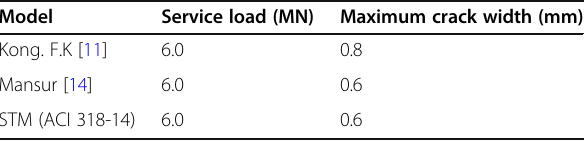
Table 2 Service loads and max. crack widths for the different